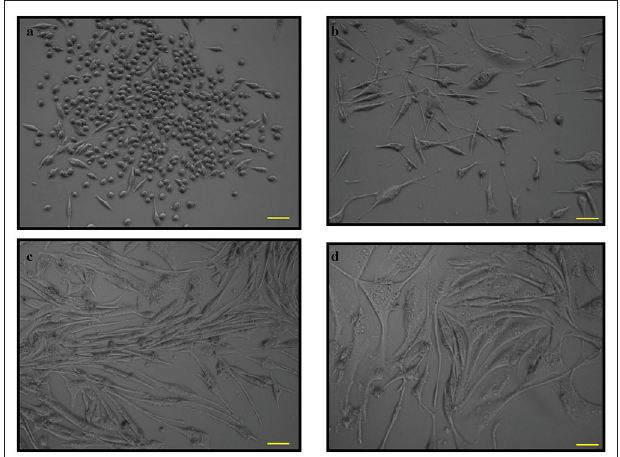
FIGURE 1 | The phase contrast microscopy images of PC12 cells. PC12 cells with absence of nerve growth factor (NGF) at (a) . 12h and (b) . 24h and PC12 cells with NGF at (c) . 48h and (d) . 72h. Pictomicrographs were taken with original magnification (10 × ); the scale bar represents 100 µ m.